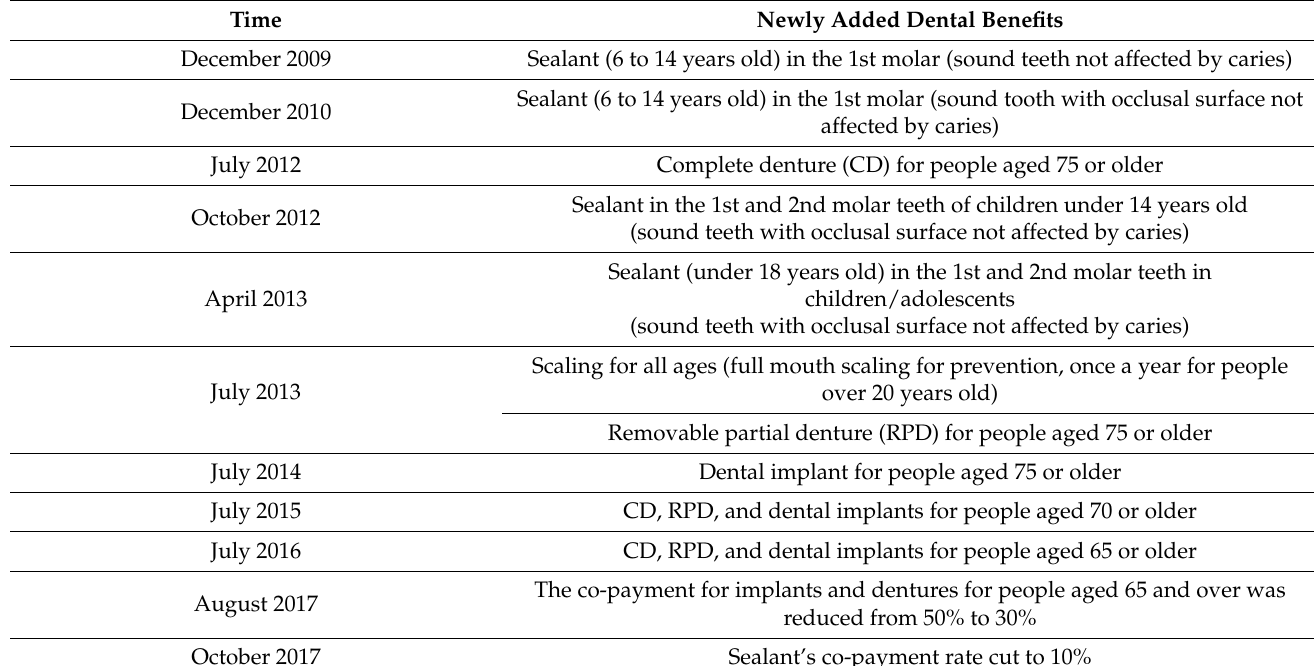
Table 1. Expanding dental healthcare coverage of the National Health Insurance.